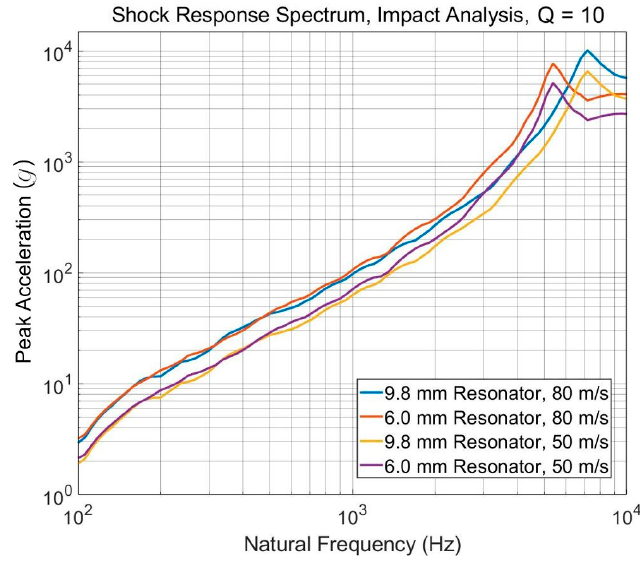
Figure 21. Parametric study through numerical analysis of pyroshock simulator.